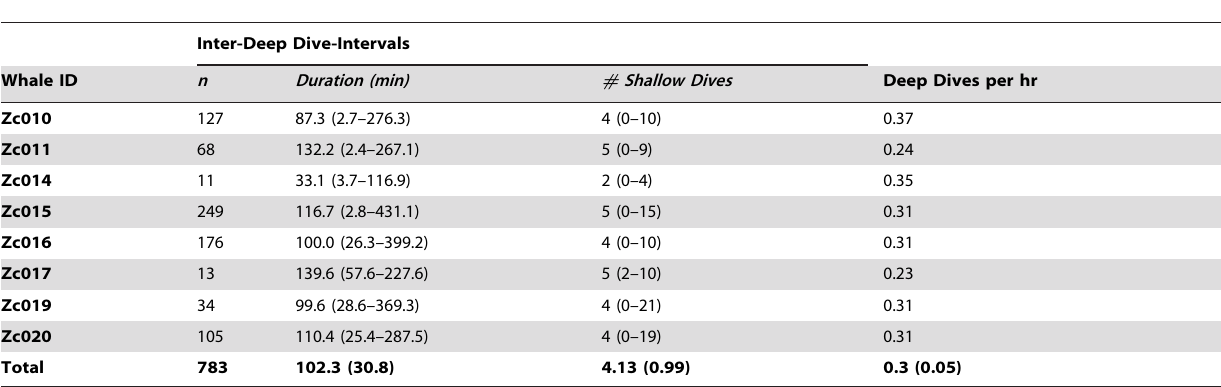
Individual table values are medians, with ranges in parentheses. The IDDI represents the period from the end of one deep dive to the beginning of the next deep dive, where there was no gap in dive data. Datasets are summed and group means (s.d.) are calculated across individuals at the bottom of the table. doi:10.1371/journal.pone.0092633.t003 PLOS ONE |